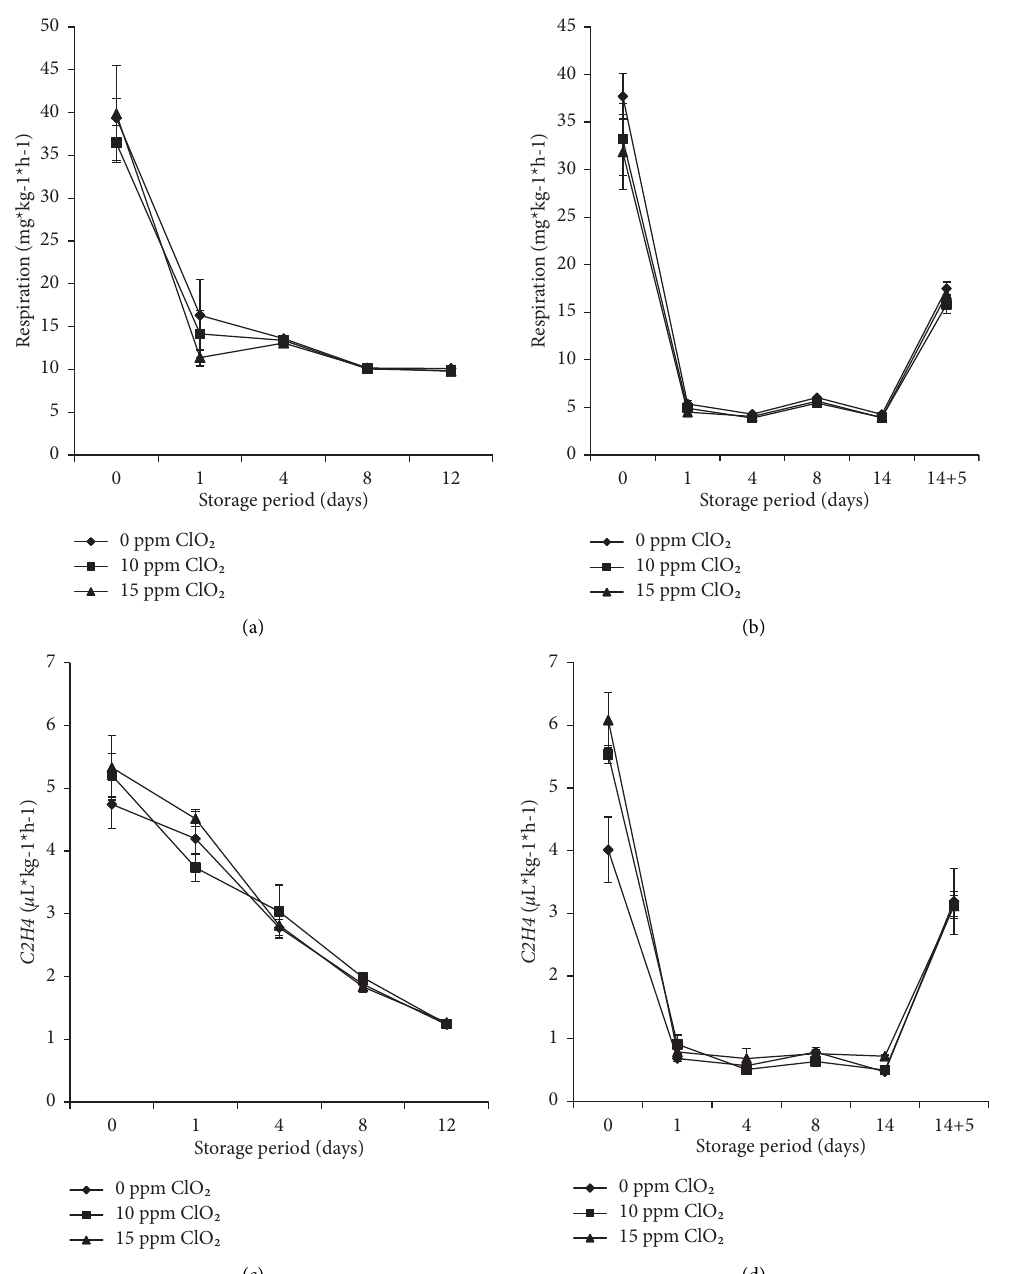
Figure 1: Efect of ClO ° C for 12 days and (b) 4 ° C for 14 days followed by 5 days 2 treatment on the respiration rate of tomatoes stored at (a) 13 at 20 ° C, and ethylene production in tomatoes stored at (c) 13 ° C for 12 days and (d) at 4 ° C for 14 days followed by 5 days at 20 ° C. Data are represented as the mean ± standard error (SE) of three replicates. Efect of ClO 2 treatment on fruit